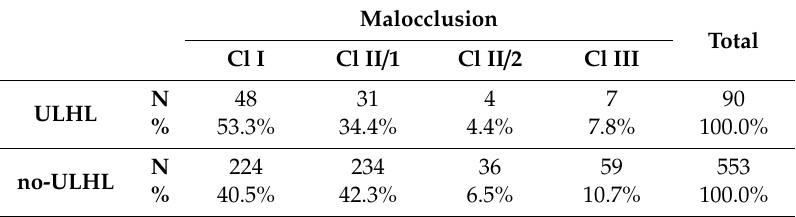
Table 2. Chi-square table presenting the prevalence of the ULHL and without it (no-ULHL), according to malocclusion. No significant difference was found in the prevalence of the ULHL between the different malocclusions.